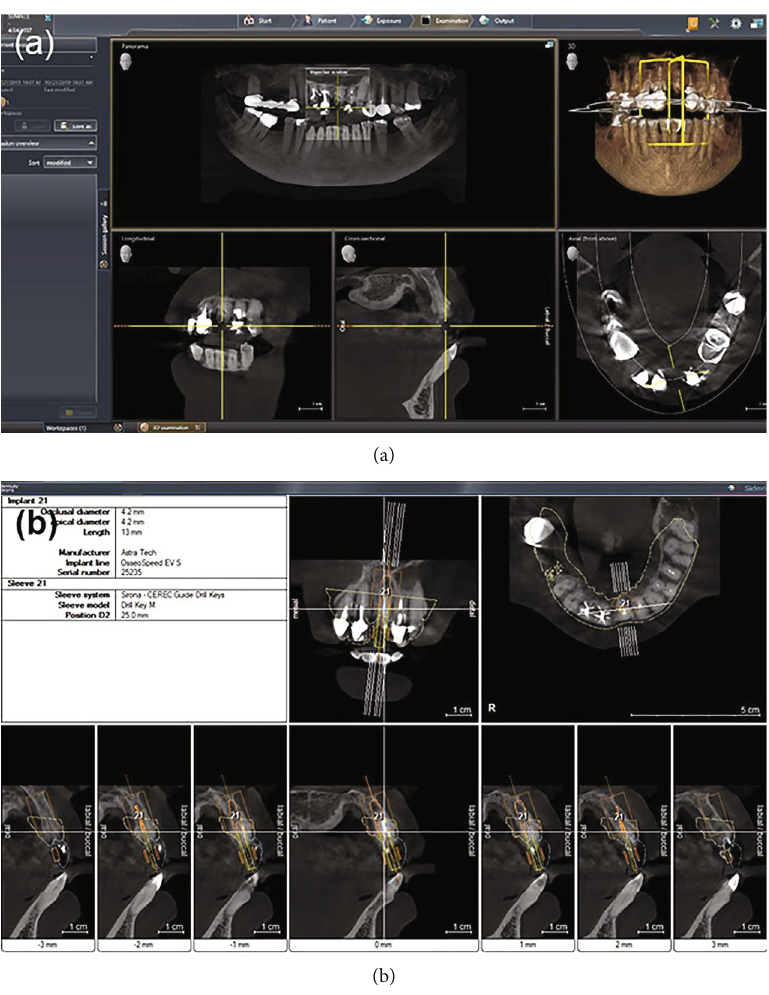
Figure 2: Radiograph for the diagnosis and treatment planning (a, b).